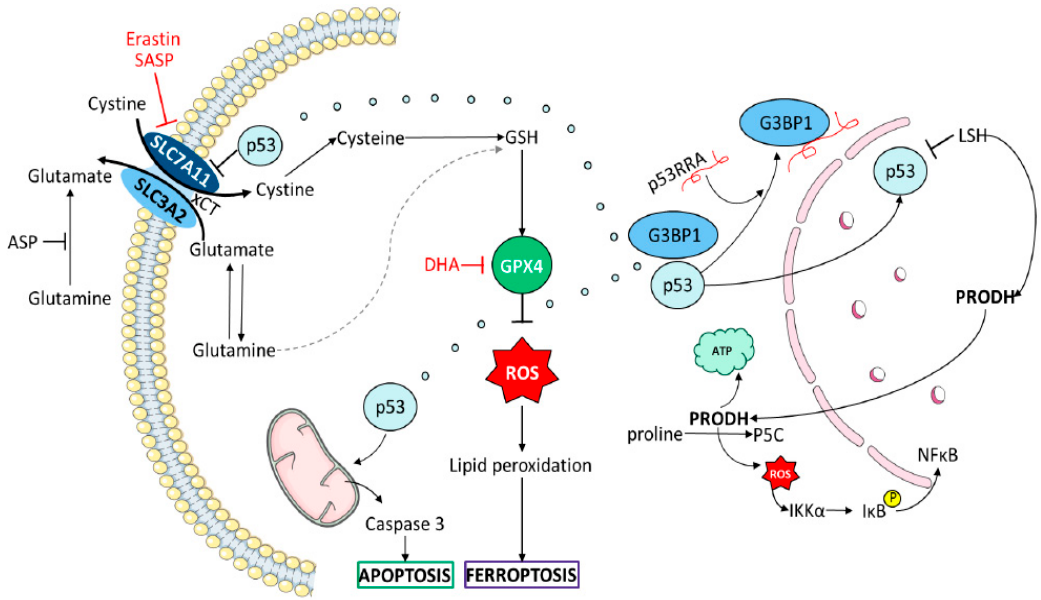
Figure 2. Ferroptosis is the result of an accumulation of lipid reactive species. ROS production is inhibited by metabolites derived from the amino acid cysteine, and glutamine by the antiporter xCT ( − ) transporter/SLC7A11. In addition, the p53-related lncRNA (P53RRA) is also involved in the regulation of SLC7A11. For a full explanation, see the section on Glutathione synthesis and ferroptosis cystine-glutamate antiporter (xCT)-GSH/GPX pathway and p53.